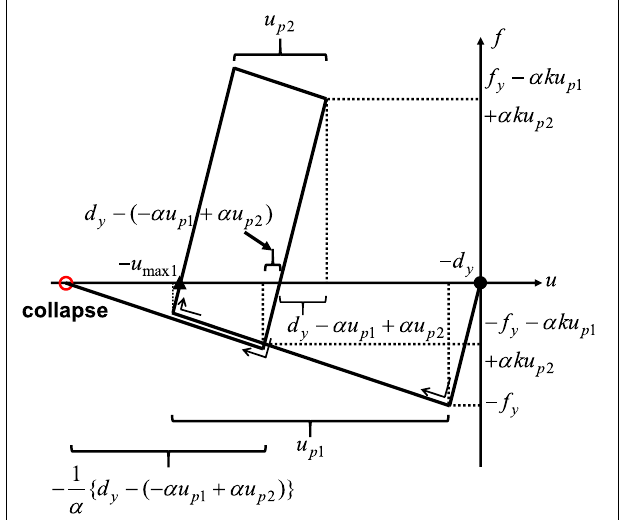
FIGURE 8 | Restoring force characteristic corresponding to Pattern 3 (Stability limit after the second impulse with closed-loop in restoring force characteristic)